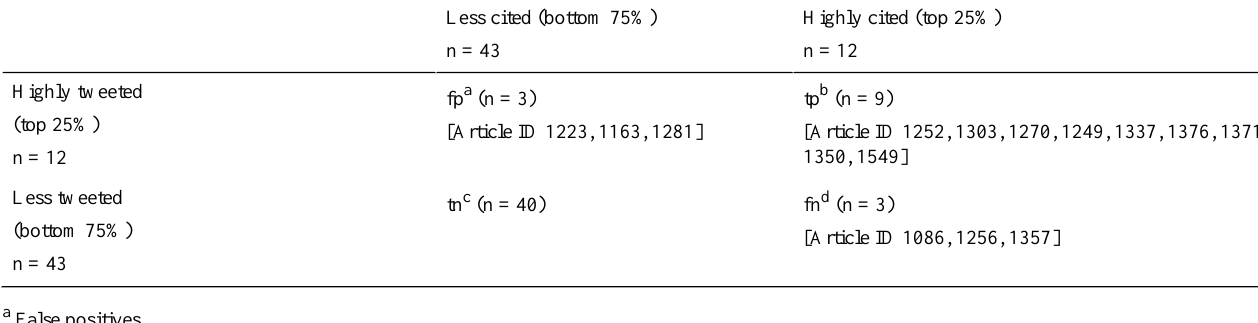
Table 2. 2 × 2 table using top-tweeted articles as a predictor for top-cited